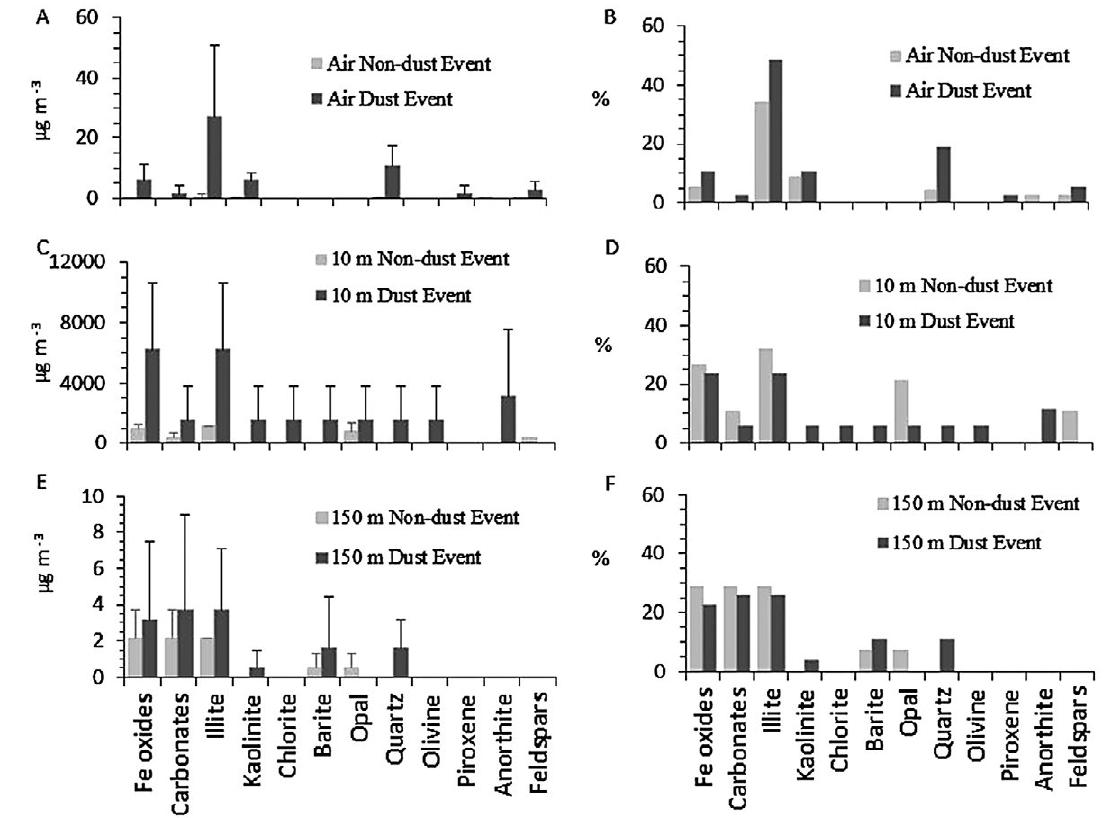
Fig. 7. – Mineral concentration (mg m –3 ) and percentage (%) in airborne samples (A, B), at 10 m depth (C, D), and at 150 m depth (E, F) during dust and non-dust events. Error bars are the standard